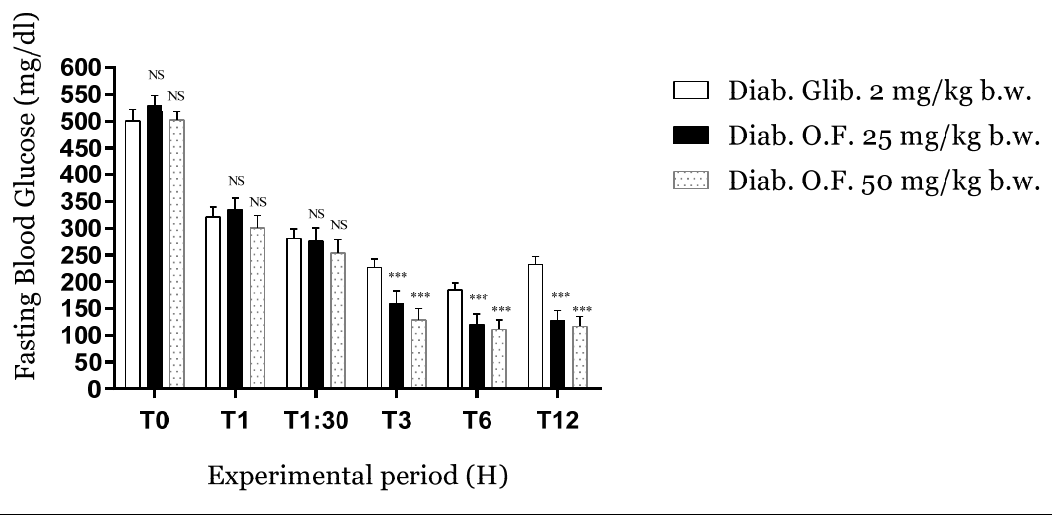
Figure 3. Effect of oleaster leaves on hyperglycemic status of Alloxan-induced diabetic mice during the experimental period of 12 h. Values are expressed as mean ± SD ( n = 5 mice). NS: non-significant; *** p < 0.001 compared to diabetic control.